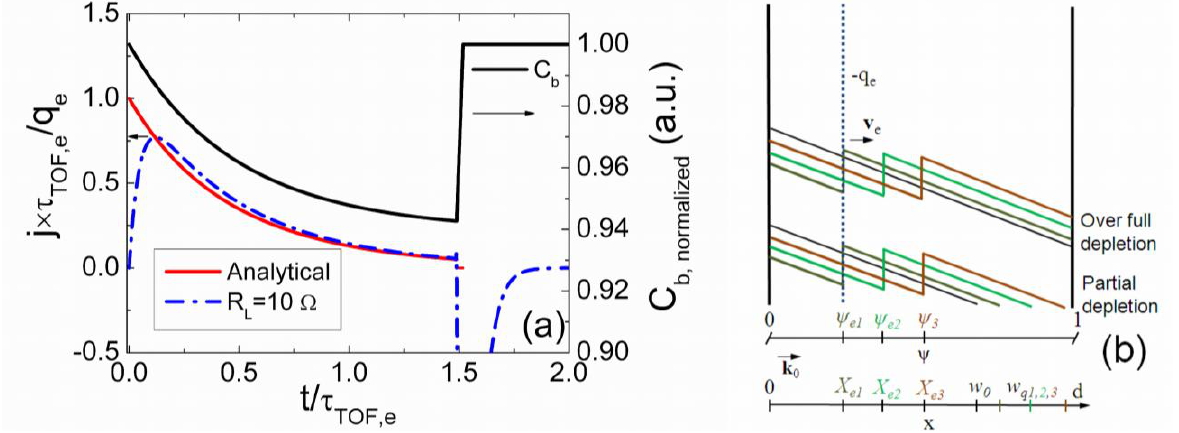
Figure 2. ( a ) Normalized current density j ×  /q transients simulated without TOF,e e including of the external circuit impact (red solid curve) and under the impact of external circuit with R = 10 Ω (dash-dotted blue curve). Solid black curve represents the barrier L capacitance variations during charge drift. ( b ) The electric field redistribution within the partially and the over-depleted diode layer during the drift of the electron